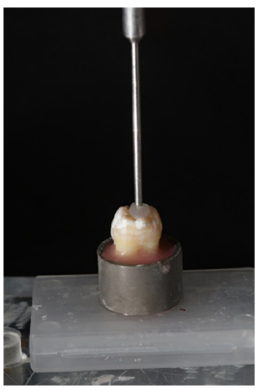
Figure 1. Sample preparation: Teeth were suspended in the center of an aluminum cylinder and mounted 2 mm apical to the cement–enamel junction in polymethyl methacrylate